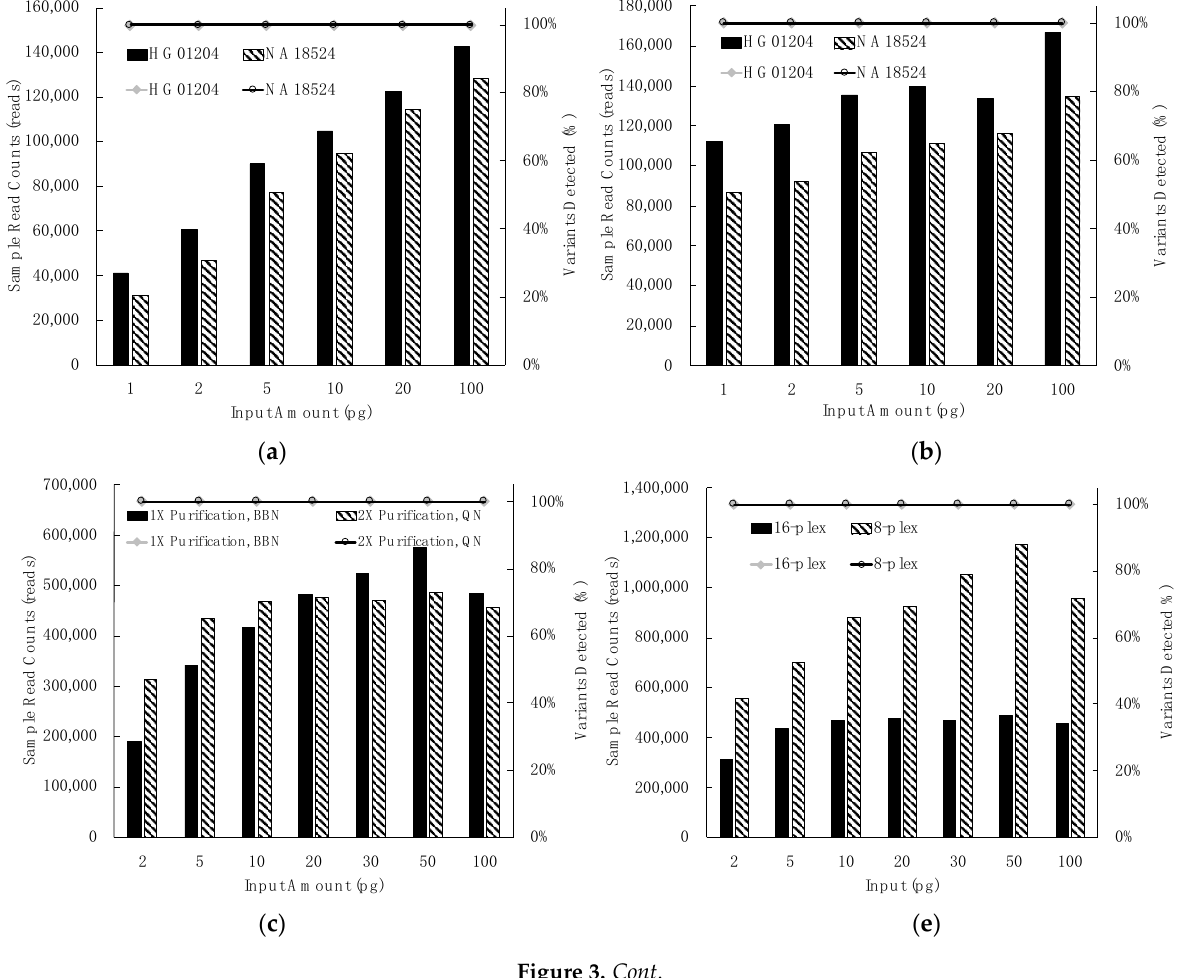
Figure 3. Sensitivity studies of the control region and mtGenome multiplexes: DNA inputs, library purification and nor- malization methods, sample plexity. Various gDNA template inputs ( x -axis) relative to total reads per sample ( y -axis, left), and relative to detection of expected variants detected under a set of condition(s) ( y -axis, right) plotted as open and closed circles shown in horizontal one atop each graph. ( a ) control region multiplex: dilution series of gDNAs HG01204 (solid bars, closed circle) and NA18524 (hatched bars, open circle). Libraries were prepared in duplicate, purified 1× and nor- malized with BBN (average of two reps plotted), ( b ) control region multiplex: dilution series of gDNAs HG01204 (solid bars, closed circle) and NA18524 (hatched bars, open circle). Libraries were prepared in duplicate, purified 2× and nor- malized with QN (average of two reps plotted), ( c ) mtGenome multiplex: dilution series of HL60 gDNA. Libraries were prepared in duplicate, purified 1×, normalized with BBN (solid bars, closed circle), or purified 2× and normalized with QN (hatched bars, open circle) (average of two reps plotted), ( d ) control region multiplex: dilution series of HL60